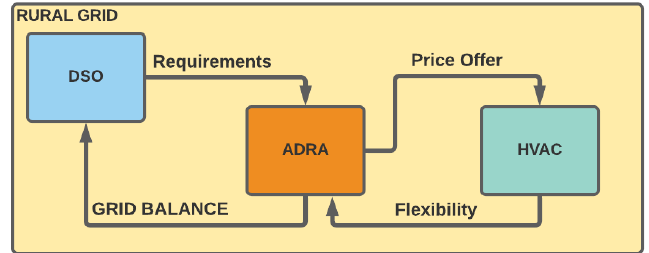
Figure 1. DSO-ADRA-HVAC Flexibility